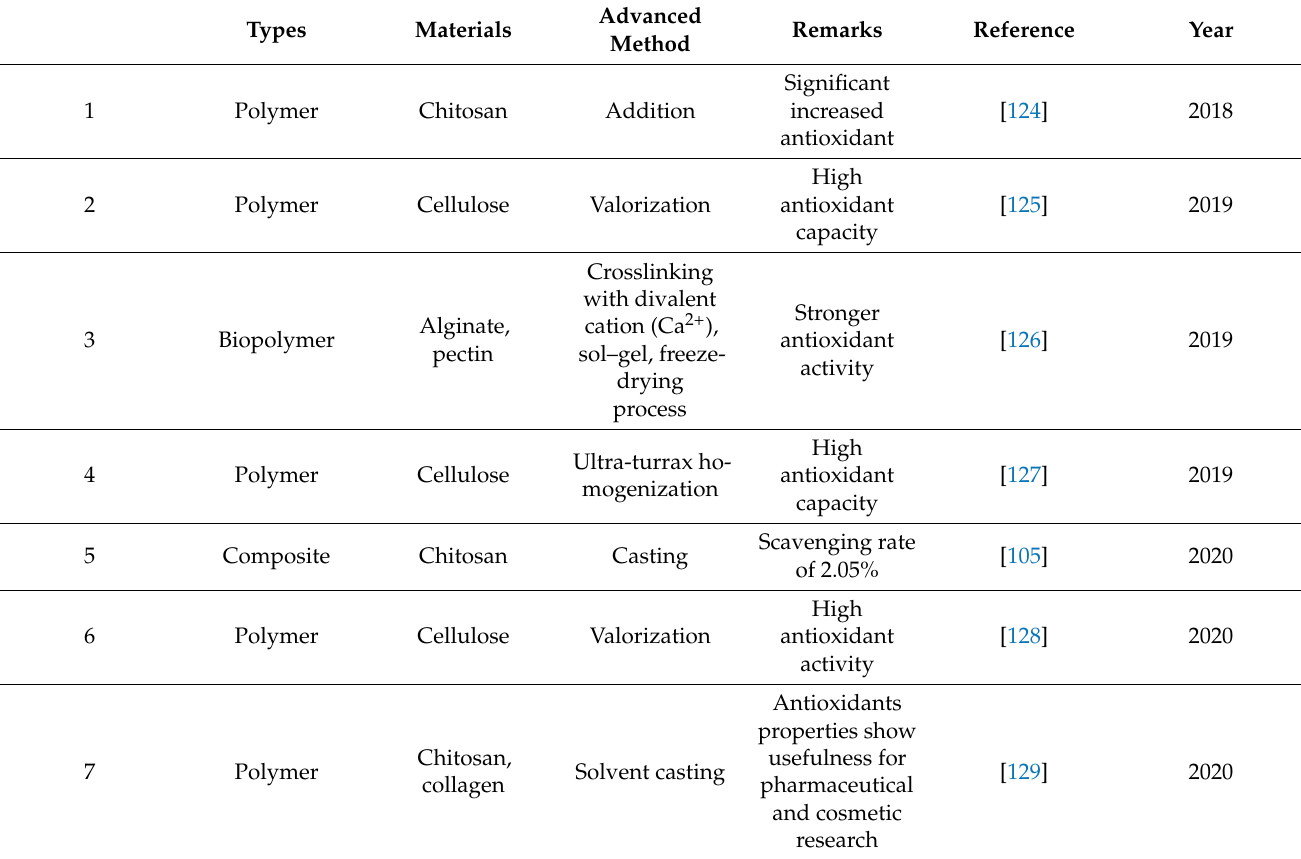
Table 5. Previous works related to antioxidant activity for various types of